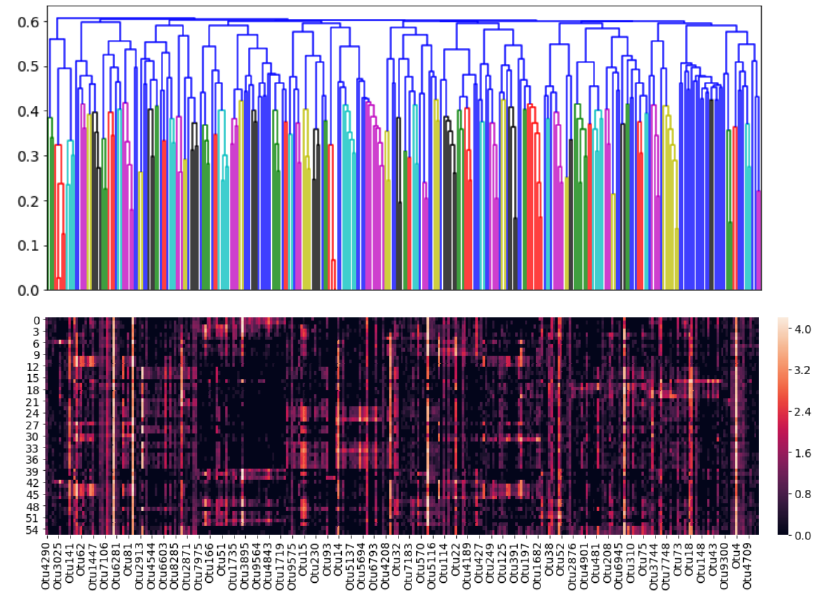
Figure 8. UPGMA dendrogram ( top ) and heatmap ( bottom ) showing log-transformed OTU abundances. The rows of the heatmap represent individual samples, while the columns represent individual OTUs. Dark colours on the heatmap represent distances close to zero and hence similar OTUs, while light colours represent large distances and hence dissimilar